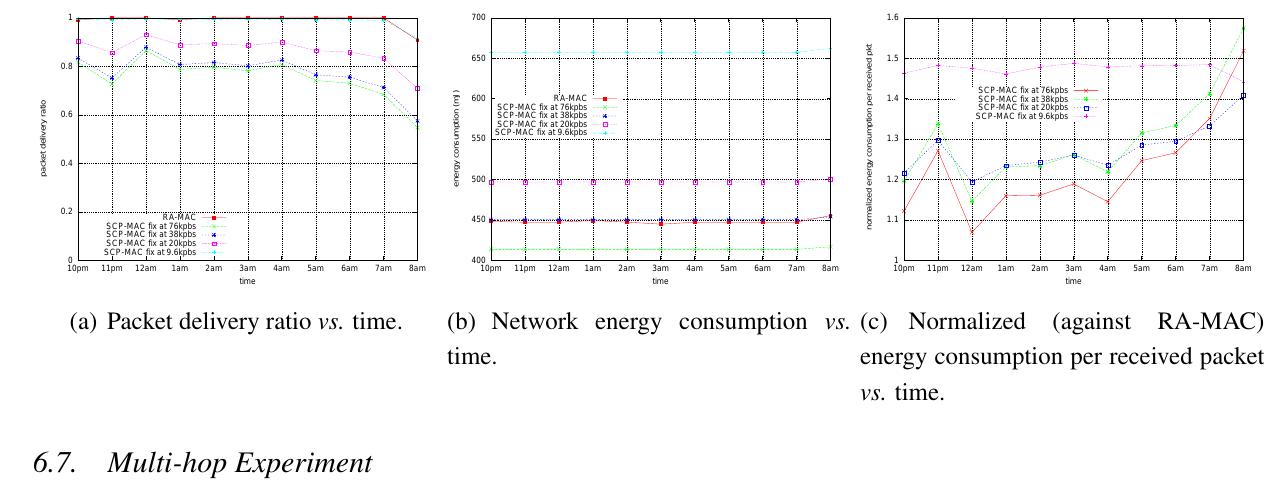
Figure 7 . Low traffic load (one packet every 20s).